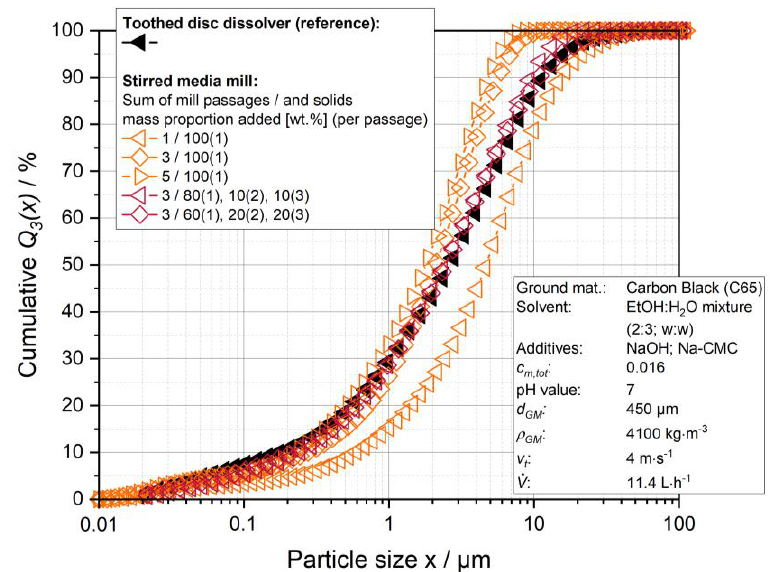
Figure 12. Particle size sum distributions Q 3 ( x ) of the deagglomerated conductive carbon black produced with the reference process in a toothed disc dissolver as well as with a stirred media mill under variation of the number of mill passages and the passage-dependent addition of the carbon black.